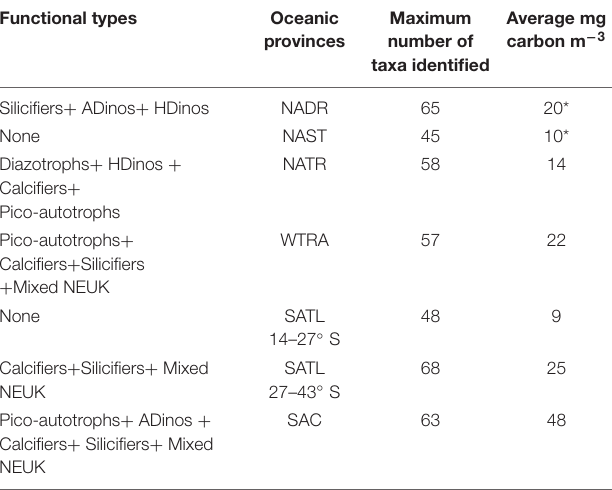
TABLE 3 | Phytoplankton functional types contributing to biomass increase along the transect. Functional types